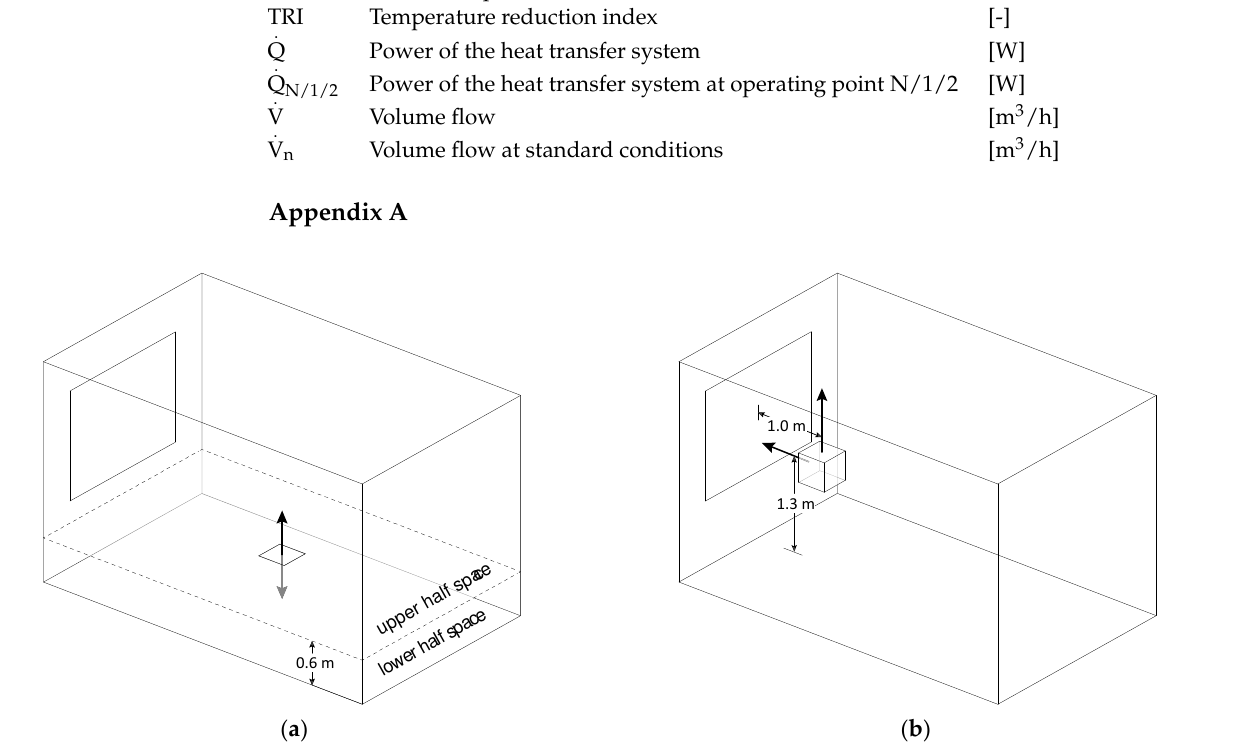
Figure A1. Visualisation of the calculation method of the radiation asymmetry according to the half-space method ( a ) and ceiling-façade method ( b ).